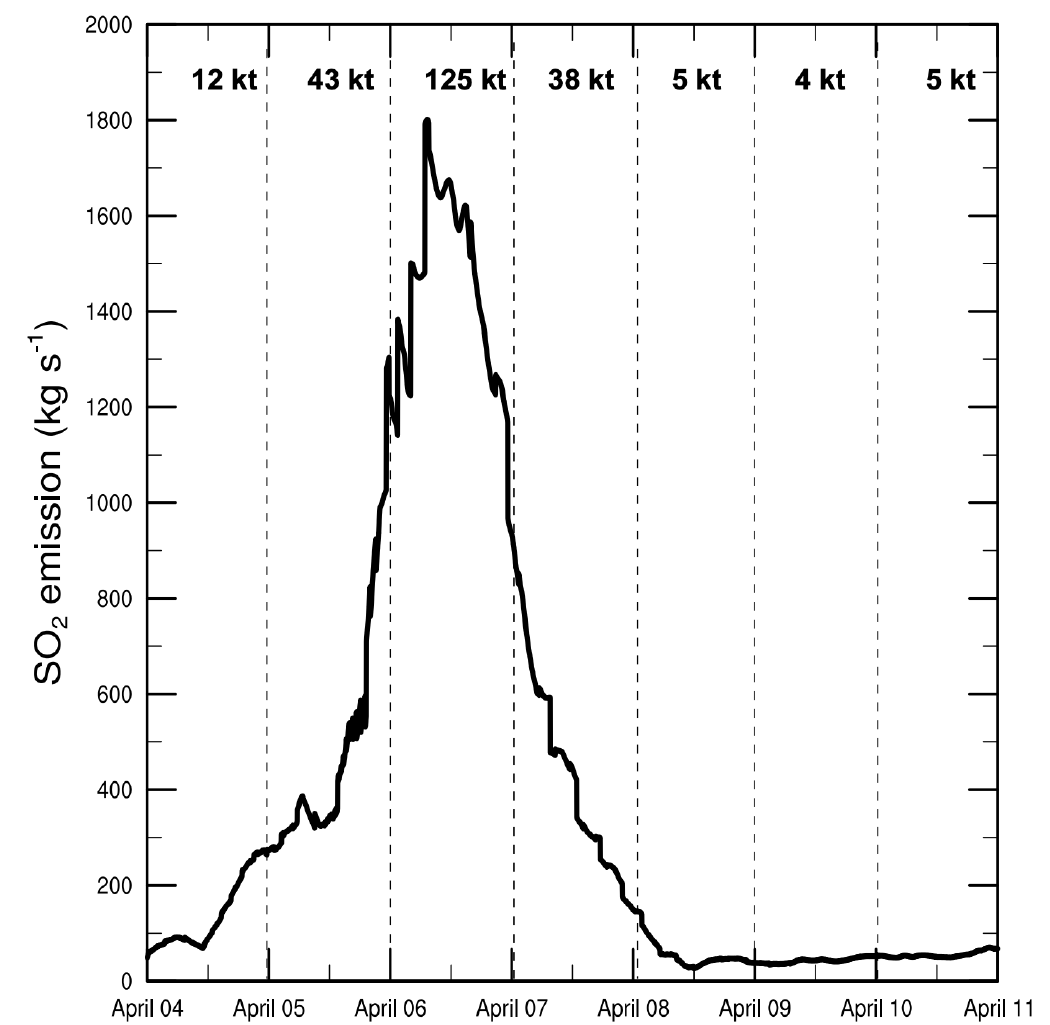
Figure 4. Estimation of SO 2 emission between 4 and 11 April from